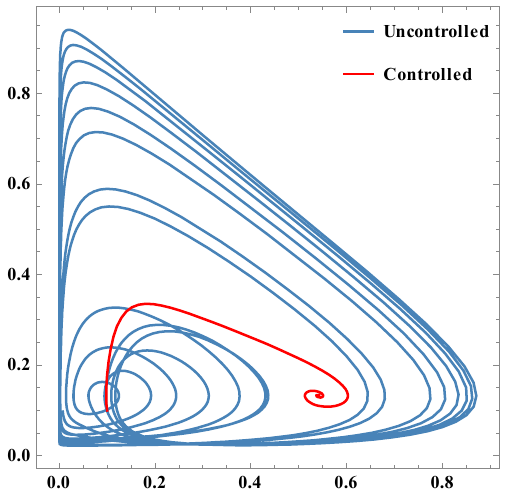
Figure 9. Parametric plots between x 3 & x 1 .